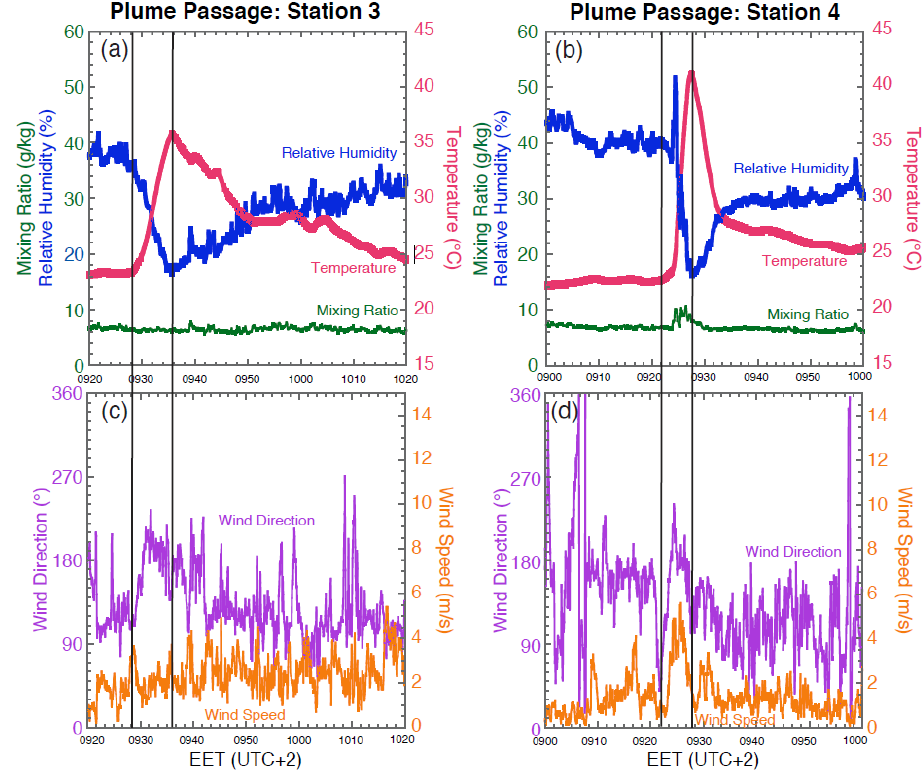
Fig. 5. Observations at the top of two meteorological stations outside of the perimeter of the burning